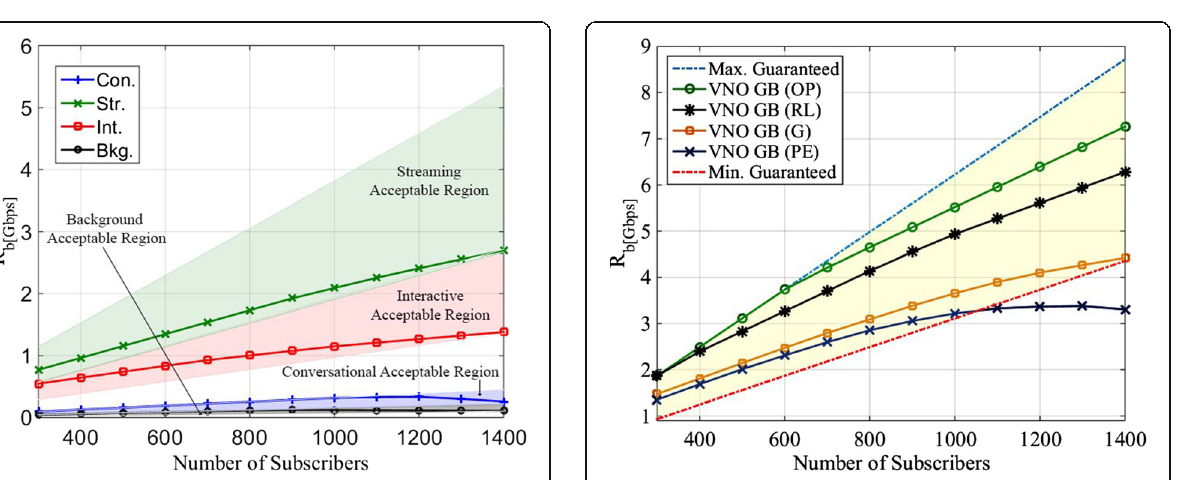
Fig. 7 Data rate allocated to service classes of VNO GB Fig. 8 Data rate allocated to VNO GB in different